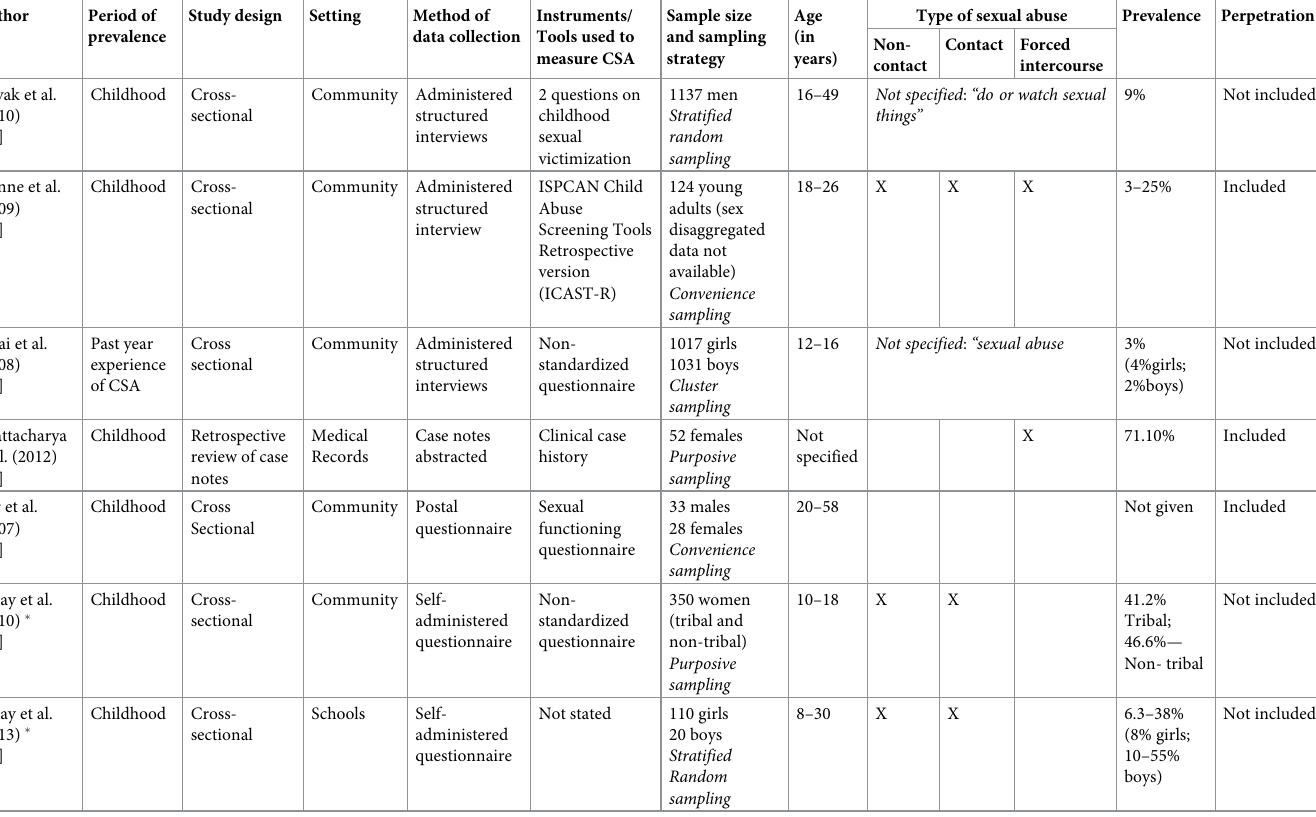
Table 4. Characteristics of quantitative and mixed-method studies included in the review with school/college, clinical, and community